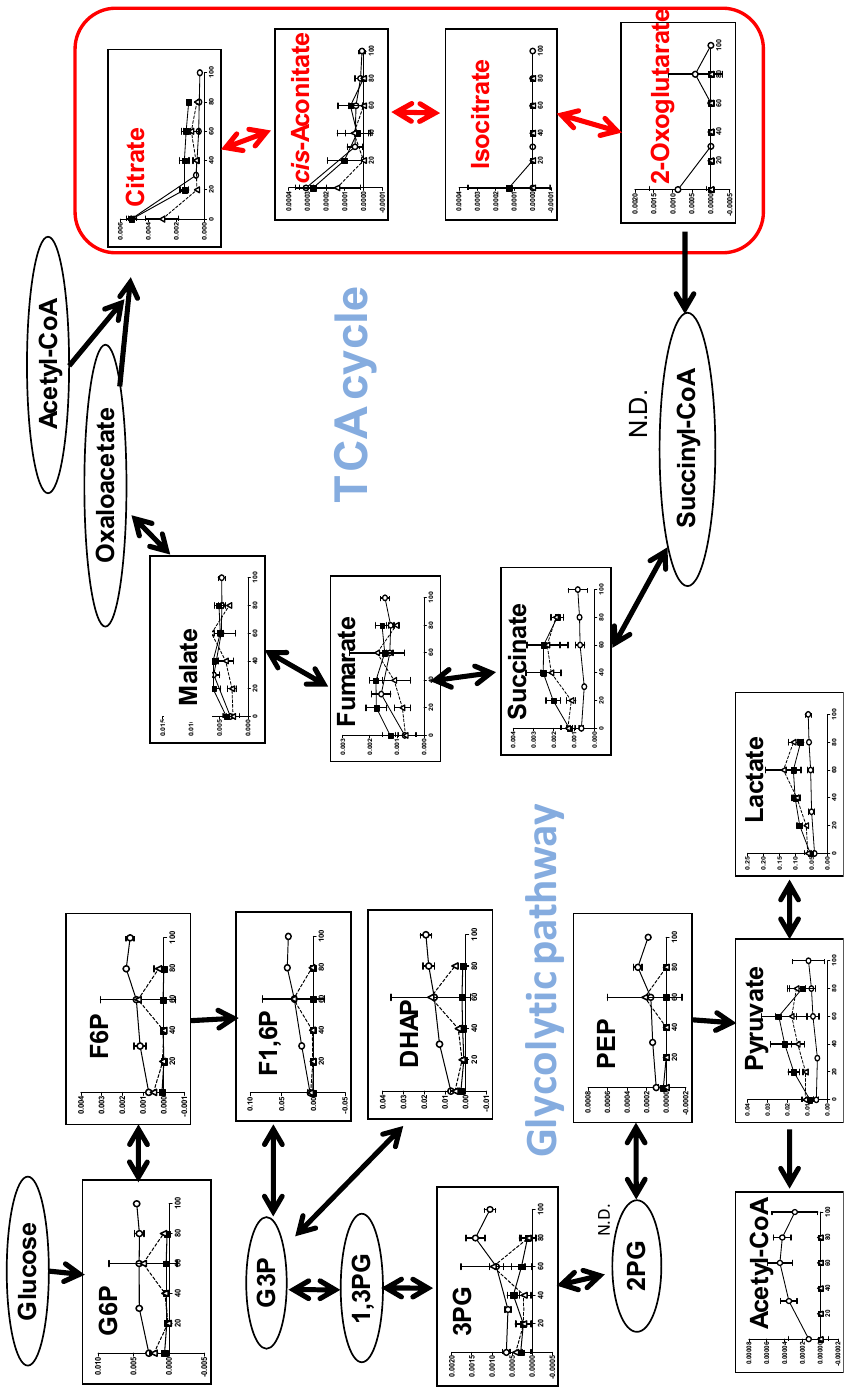
Figure 10. Eugenol suppressed the TCA cycle. HPC ( 〇 ), HPLF ( ■ ), HGF ( △ ). Vertical axis, μ mol/cell. Three groups were compared by one-way ANOVA (no post test).